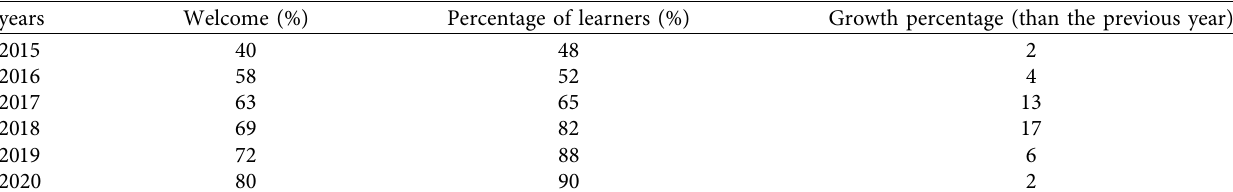
Table 4: The development trend of dance based on media interaction from 2015 to